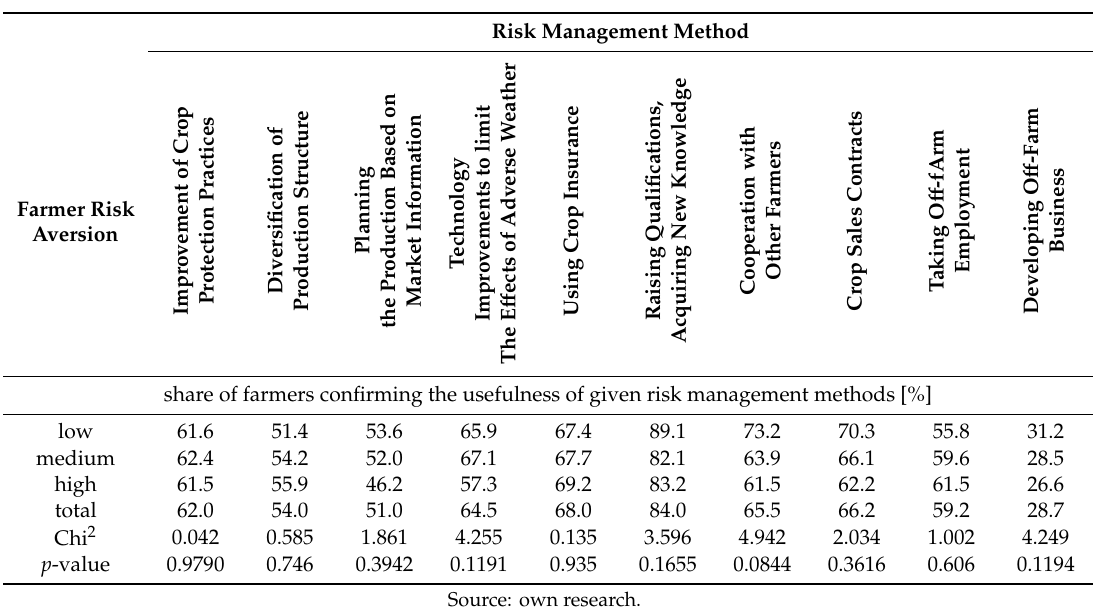
Table 6. Assessment of the usefulness of the selected risk management methods regarding the level of farmers’ risk